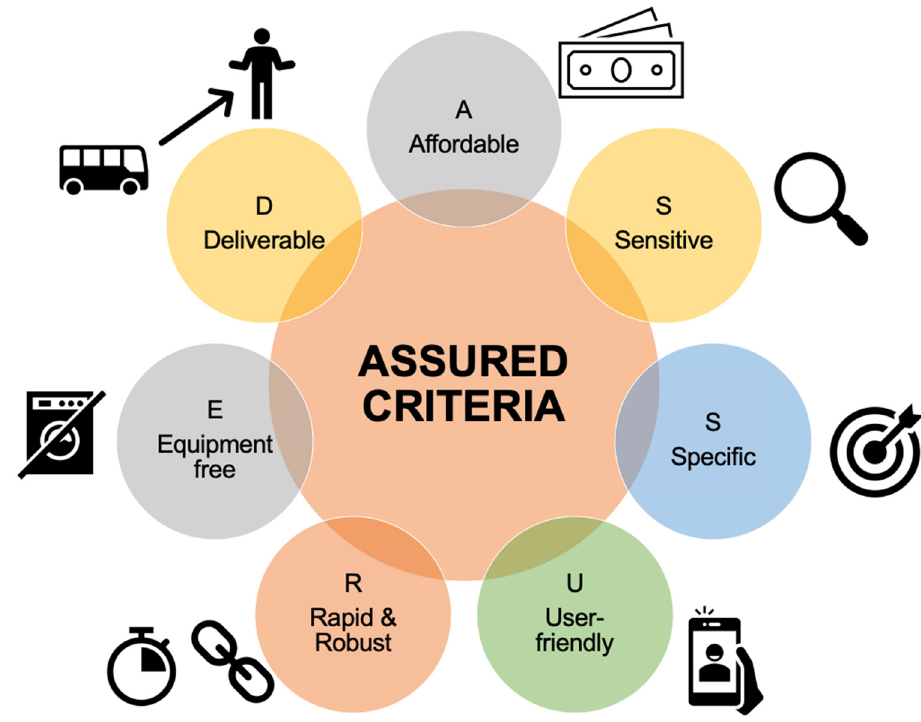
Figure 2. A schematic representation of the WHO’s ASSURED criteria for diagnostics.